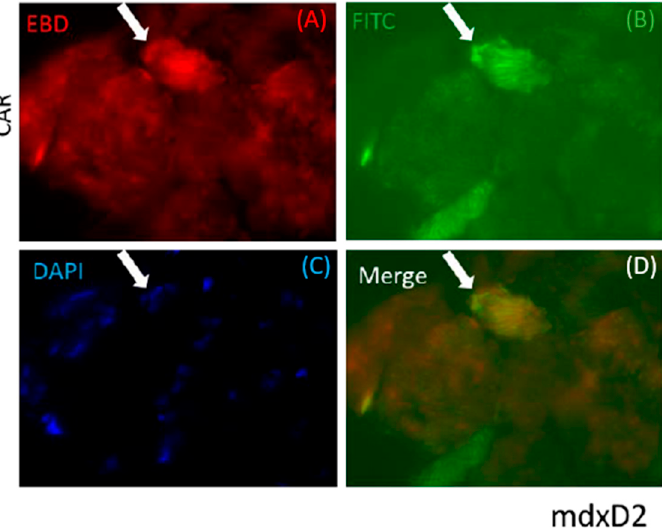
Figure 1. The CAR peptide co-localized to damaged (indicated by EBD staining) muscle cells in the mdxD2 mice. The quadriceps of these mice were directly injected with CAR-FITC peptide and harvested 2 h later. The EBD positive fiber demonstrated co-localization with FITC coupled CAR peptide (arrow). Slides were fluorescently visualized with: ( A ) EBD for membrane permeability, ( B ) directly for the FITC peptide, ( C ) DAPI for the nuclei, and ( D ) merged images. Original magnifica- tion was 40×.